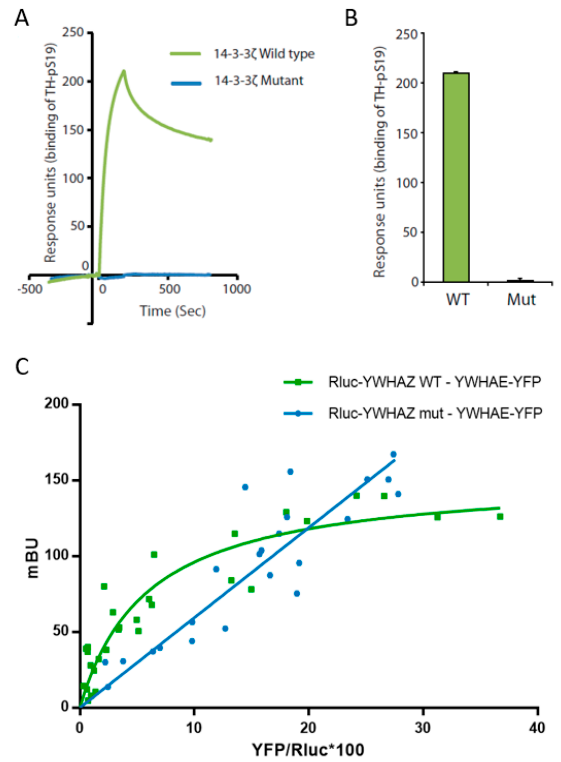
Figure 2. Characterization of mutant 14-3-3 ζ binding capacity. ( A ) Binding of Ser19 phosphorylated human tyrosine hydroxylase (25 nM) to immobilized wild-type GST-14-3-3 ζ (green) or mutant GST-14-3-3 ζ (blue) using surface plasmon resonance (Biacore 3000, see Materials and Methods for details). The proteins were expressed in the BL21 Codon Plus E. coli strain and purified prior to the analysis. ( B ) The binding response for Ser19 phosphorylated tyrosine hydroxylase (25 nM) at the end of the injection was compared between 14-3-3 ζ WT or Mut and Ser19 phosphorylated tyrosine hydroxylase (TH-pS19) (25 nM) repeated by several immobilizations and injections. Data presented as means and error bars denote the standard deviation ( n = 3, p = 1.61 × 10 − 8 WT vs. Mut, two-sided t-test). ( C ) Characterization of wild-type 14-3-3 ζ (YWHAZ WT) and mutant 14-3-3 ζ (YWHAZ mut) interaction with 14-3-3 ε (YWHAE) using a bioluminescence resonance energy transfer (BRET) assay. Rluc-YWHAZ WT co-transfection with an increasing amount of YWHAE-YFP gives a saturable positive signal (green), whereas the signal obtained co-transfecting Rluc-YWHAZ mut with an increasing amount of YWHAE-YFP fits with a linear regression (blue). mBU, BRET ratio expressed in milli-BRET units. The relative amount of BRET is given as a function of YFP / Rluc*100, where YFP corresponds to the fluorescence signal due to the increasing amount of donor and Rluc corresponds to the stable luminescence signal measured at 10 min. Values shown correspond to independent experiments ( n = 4).